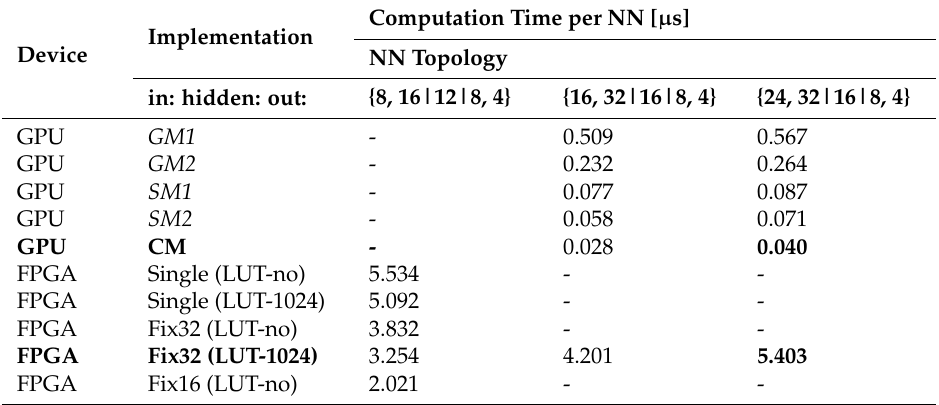
Table 9. Final summary of inference on GPU and FPGA for a batch of 1024 NNs with different NN topologies (selected solutions in